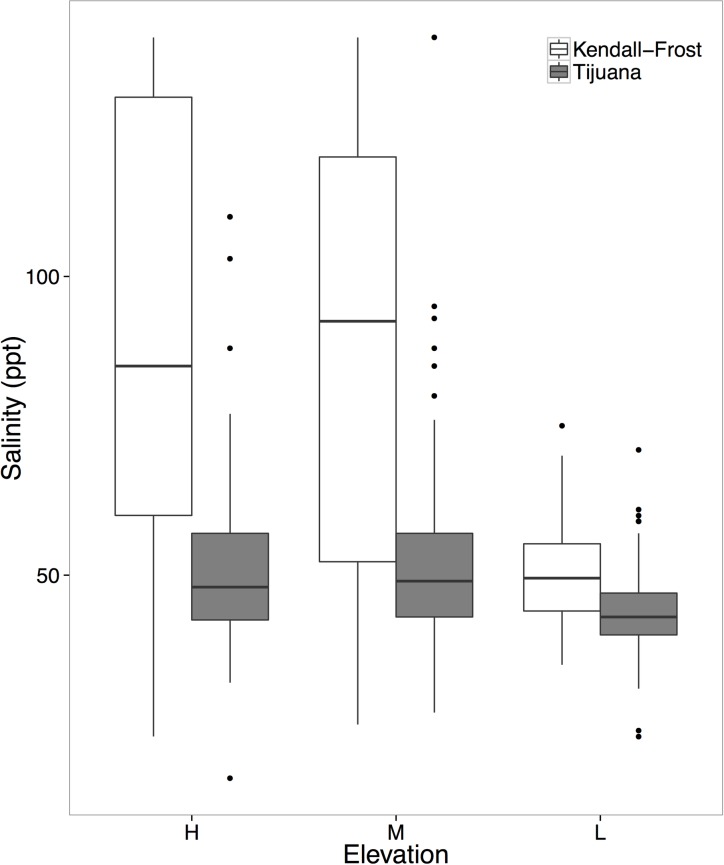
Salinity (parts per thousand) at Kendall-Frost (white) and Tijuana (gray) at high, medium and low elevation (left to right).